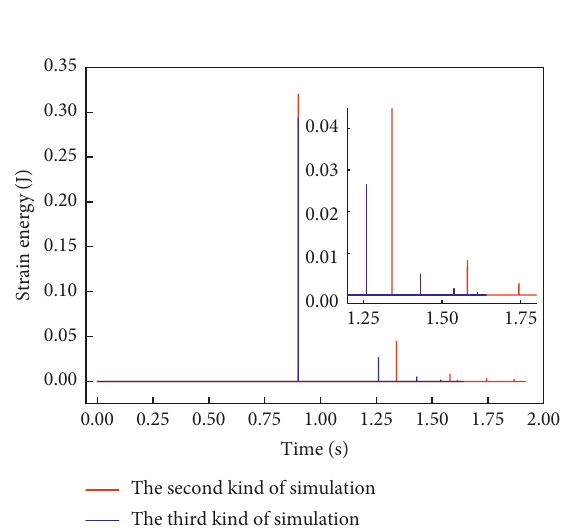
Figure 15: Potential energy.